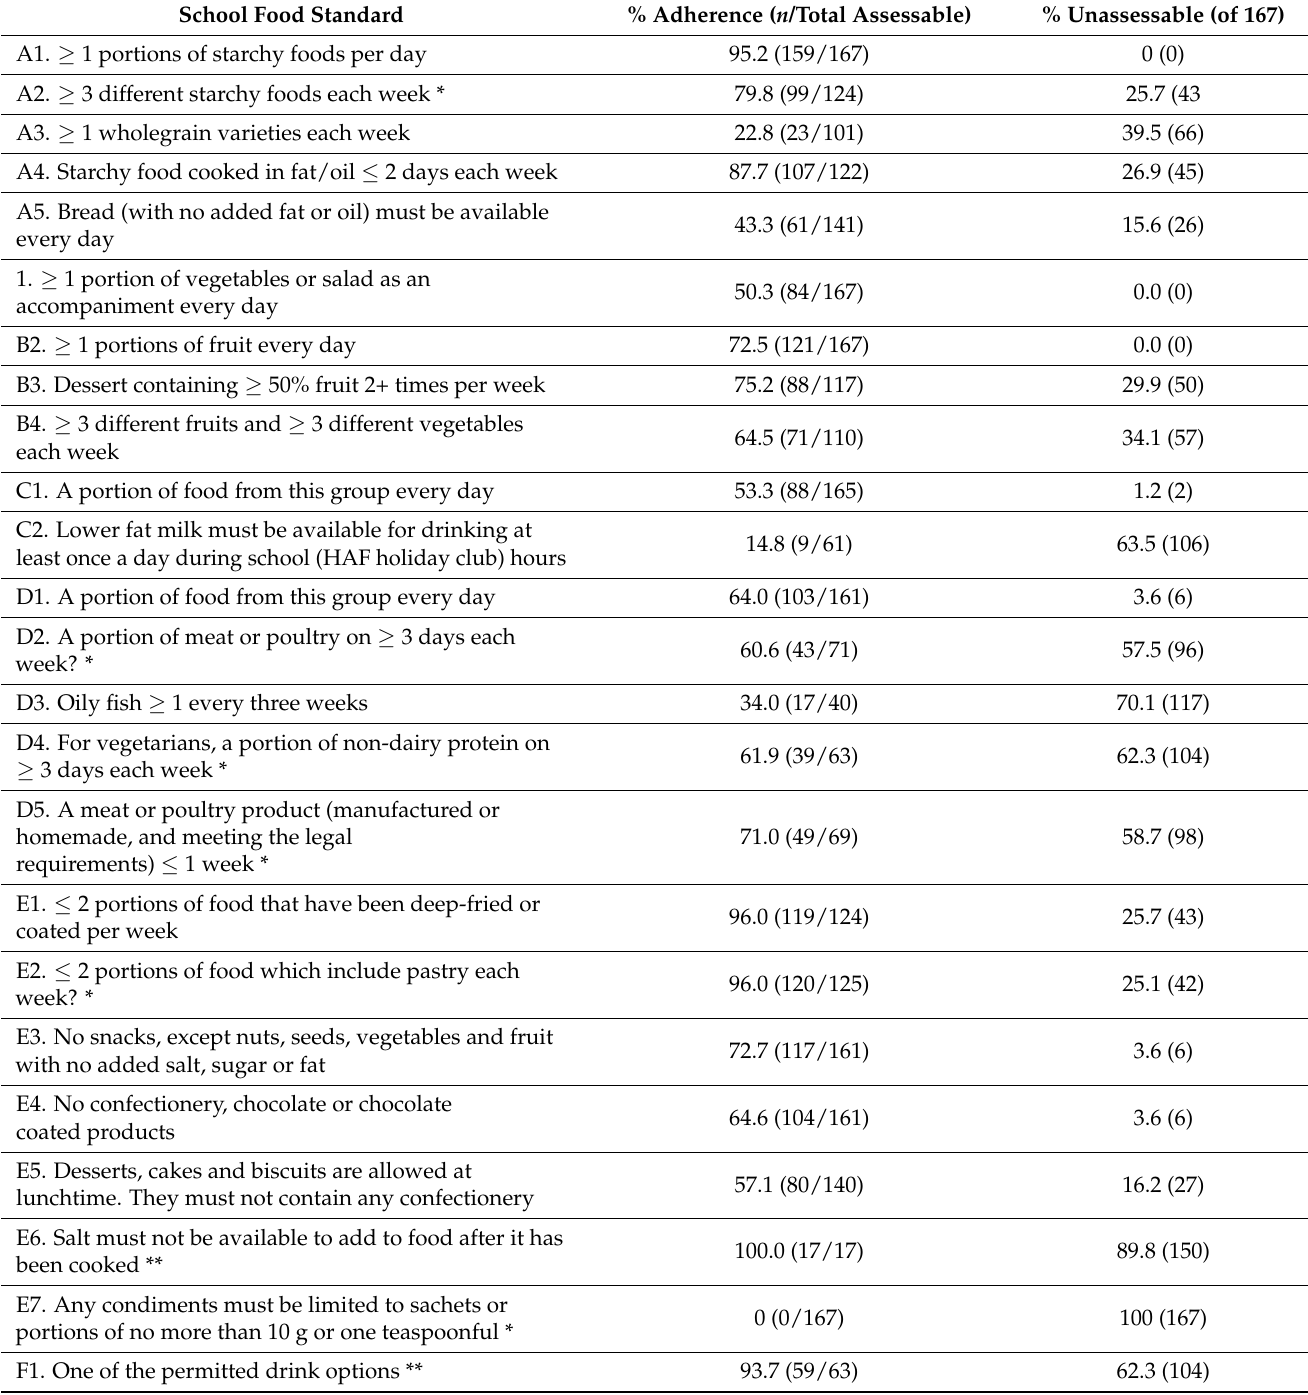
Table 2. Menu adherence to each element of the School Food